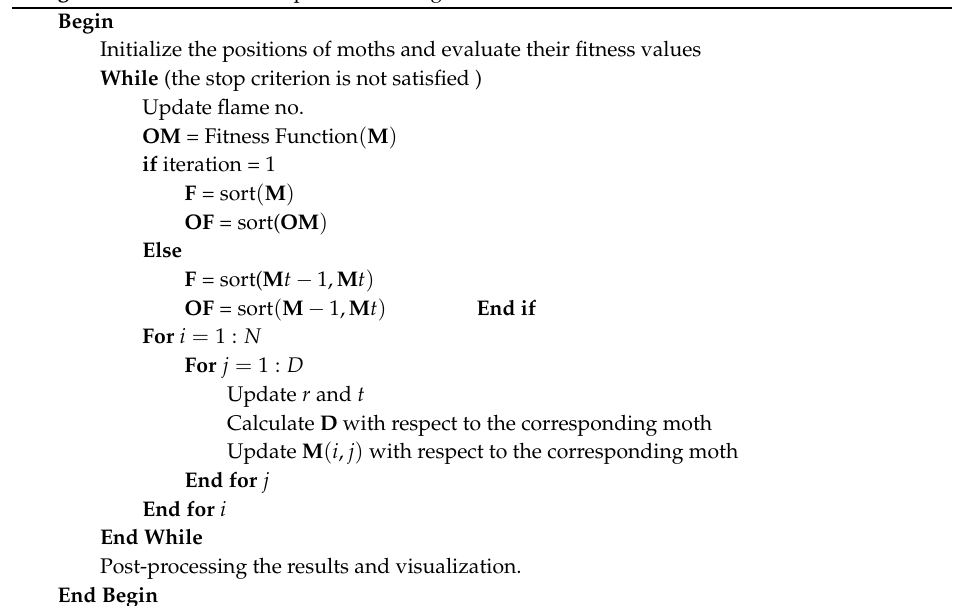
Algorithm 5: Moth-flame Optimization